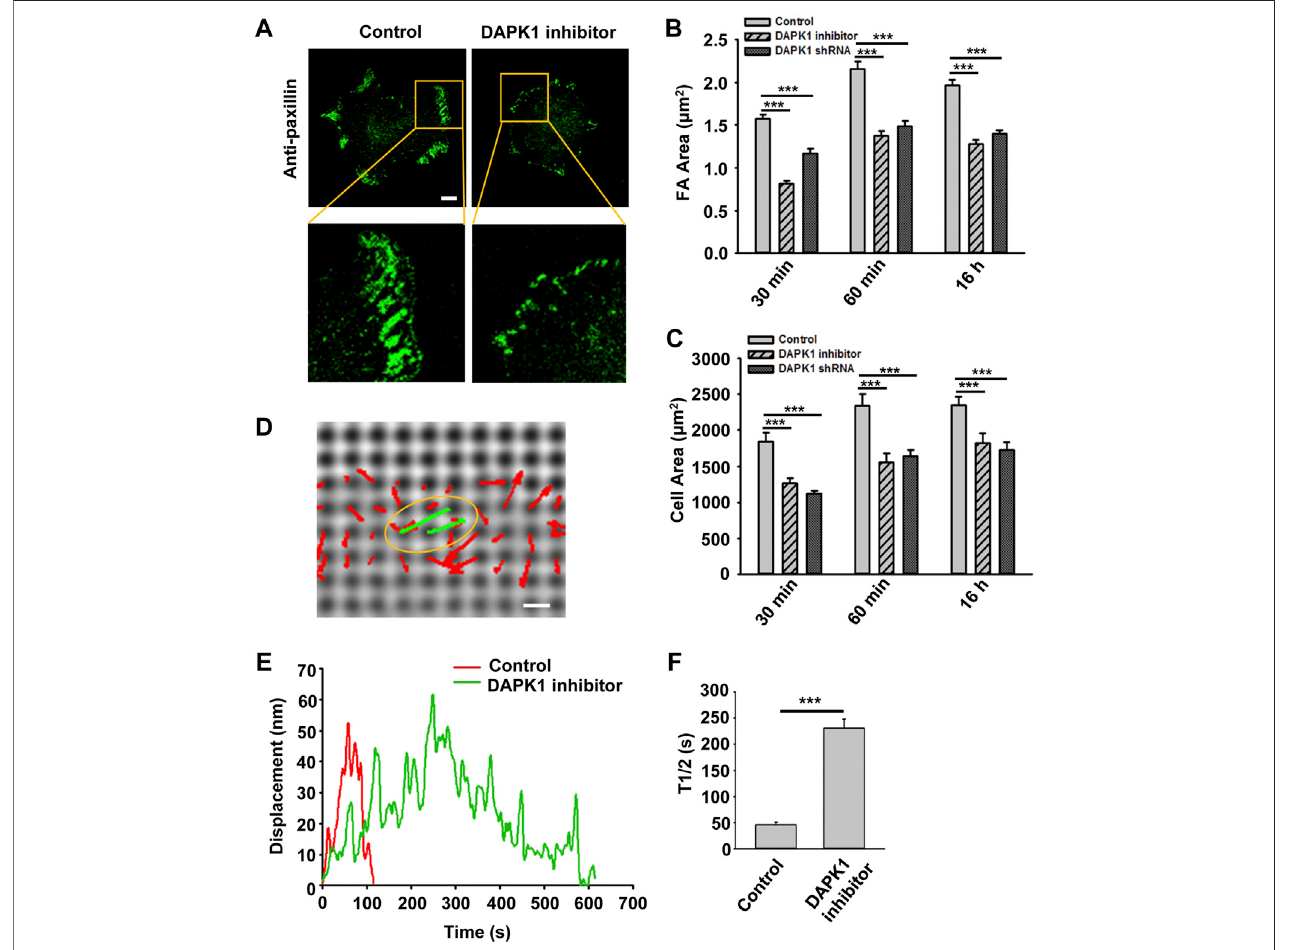
FIGURE2| DAPK1 regulatesadhesion growthandforceproduction. MEFstreatedwithDAPK1inhibitor orstableDAPK1shRNAMEFswere fi xedafterspreading on fi bronectin-coated glass dishes for 30 min, 60 min or 16 h, followed by anti-paxillin/AlexaFluor 488 immunostaining. (A) Micrographs showing the distribution of paxillinincells fi xedafterspreadingon fi bronectin-coatedglassfor30 min.Scalebar:10 μ m. (B) Quanti fi cationoftheadhesionsizes(n > 400adhesionsfrom > 10cellsin each case, mean ± SEM). *** p < 0.001. (C) Average area ± s.e.m of the cells (n > 10 cells in each case). *** p < 0.001. Experiment was repeated three times. (D) Displacements (red arrows) of pillars that show the contractile pair (green arrows marked with yellow oval) at the periphery of a spreading MFF during phase 2 of